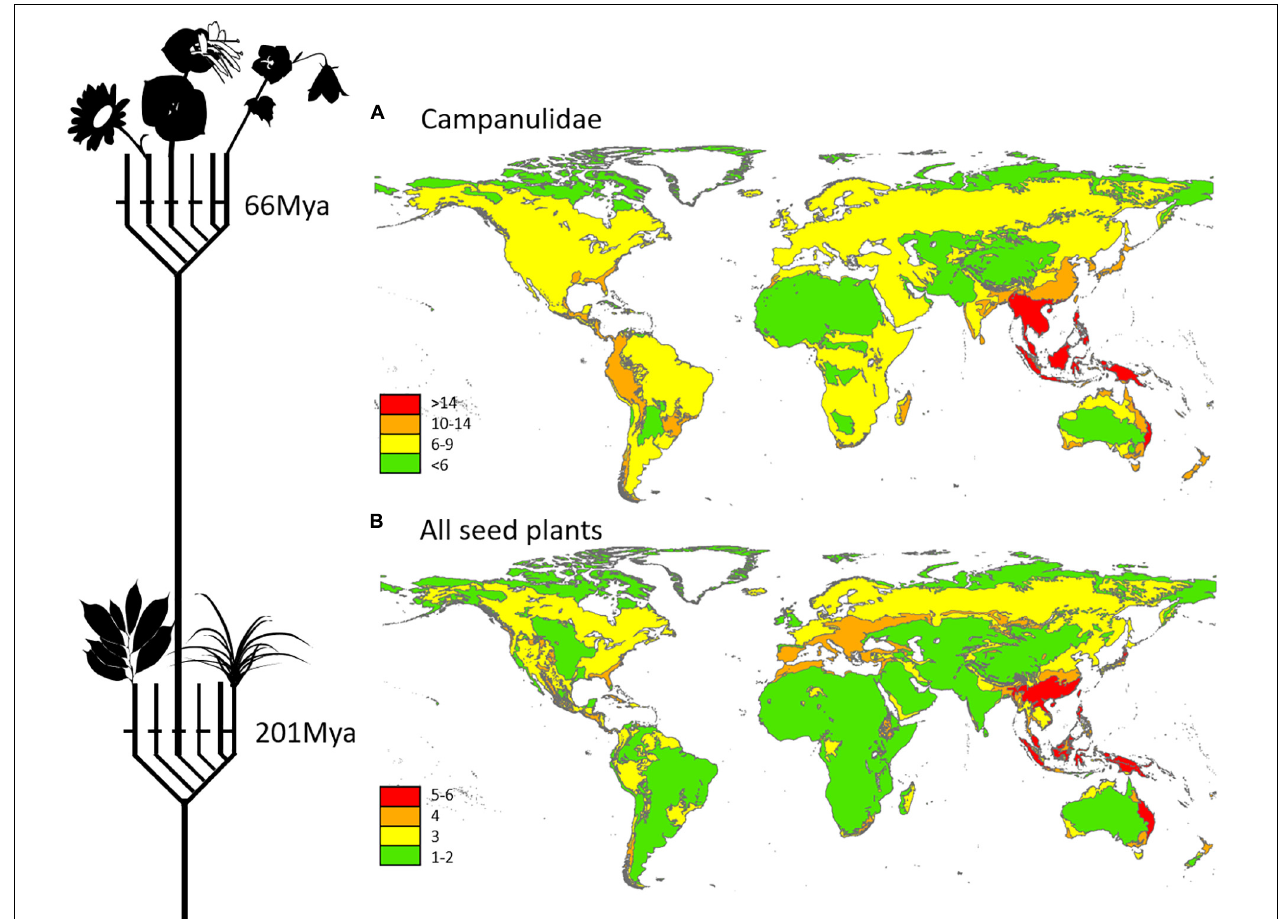
FIGURE 1 | Global patterns of plant diversity in ancient plant lineages that survived (A) the last, and (B) the last two mass extinctions. In (B) , the map comprehensively covers all seed plants; in (A) it is restricted to one selected group, the Campanulidae. Redrawn from Proche¸s et al.